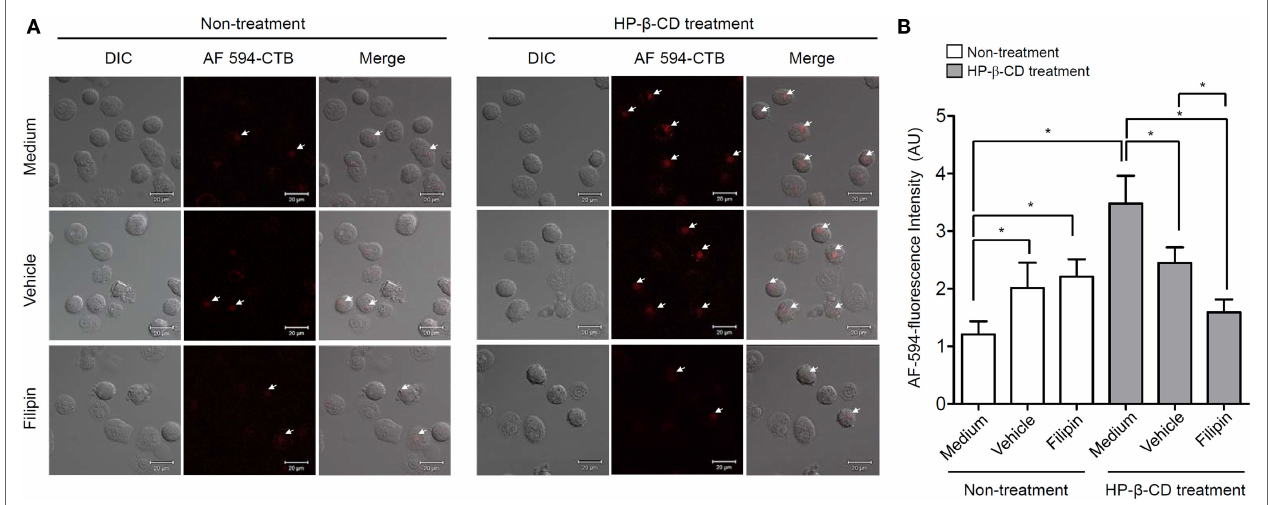
FigUre 3 | hP- β -cD triggers lipid raft formation in Dcs . Human monocyte-derived DCs (2.5 × 10 5 cells/ml) were stimulated with HP- β -CD (1 mg/ml) in the presence or absence of filipin (30 μ g/ml) or methanol as a vehicle control for 45 min. (a) Stimulated DCs were stained with Alexa Fluor ® 594-conjugated CTB, and the formation of lipid rafts on the cell surface was examined by confocal microscopy. (B) Fluorescence intensity of DCs was analyzed by ZEN software. DIC, differential interference contrast; AU, arbitrary unit. Images shown are representative of three similar